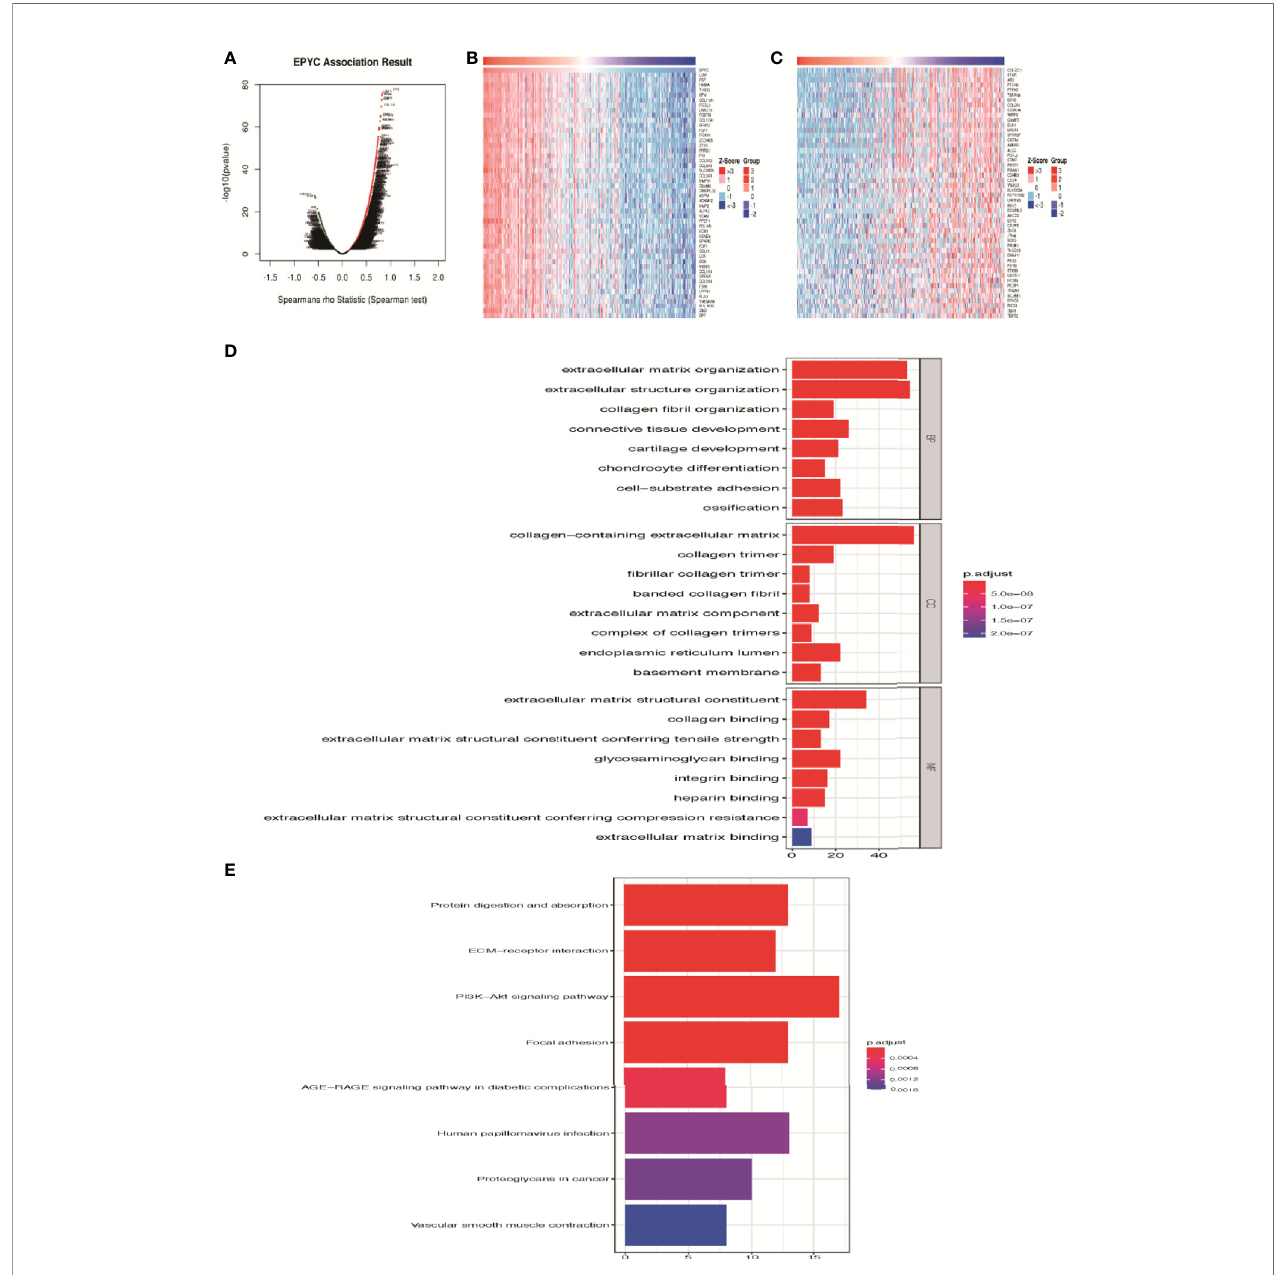
FIGURE 4 | Enrichment analysis of EPYC functional networks in ovarian cancer. (A) EPYC co-expressing genes in OCs were analyzed by spearson test (LinkedOmics). (B, C) Top 50 genes positively/negatively correlated with EPYC expression in OCs (LinkedOmics). (D) Top 8 elements signi fi cantly enriched in GO categories of top 200 genes positively correlated with EPYC expression. (E) KEGG pathway analysis of top 200 genes positively correlated with EPYC